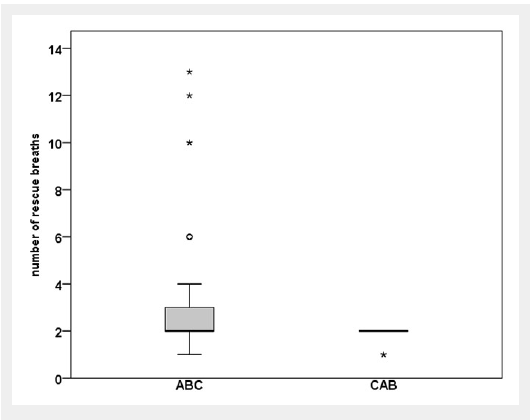
Box and whisker plot displaying the number of rescue breaths applied in the initial cycle consisting of 30 compressions and 2 ventilations. Teams were randomized to use either ABC or CAB as initial approach to CPR. Groups differ significantly (P = 0.006; chi- square test). * = one group; º = 3 groups.